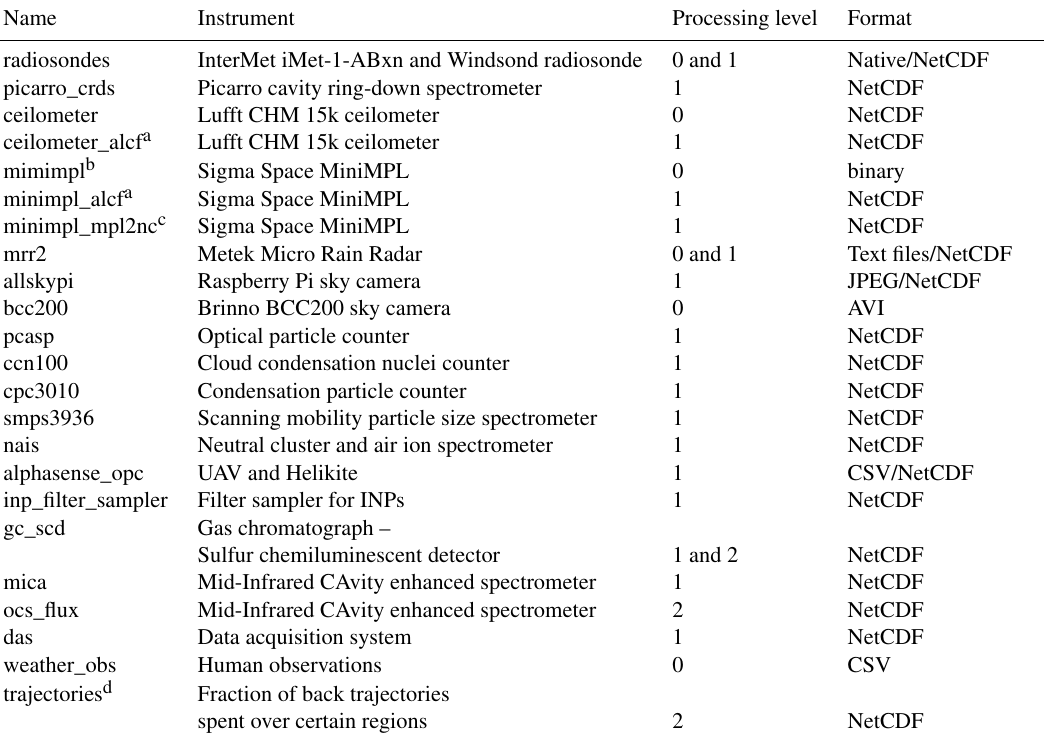
Table A1. Overview of data products available from the Zenodo TAN1802 data archive for different processing levels, i.e. level 0: raw (unformatted) data, level 1: raw data formatted into NetCDF format and quality controlled as described in the main text of the paper, and level 2: derived parameters such as sea–air